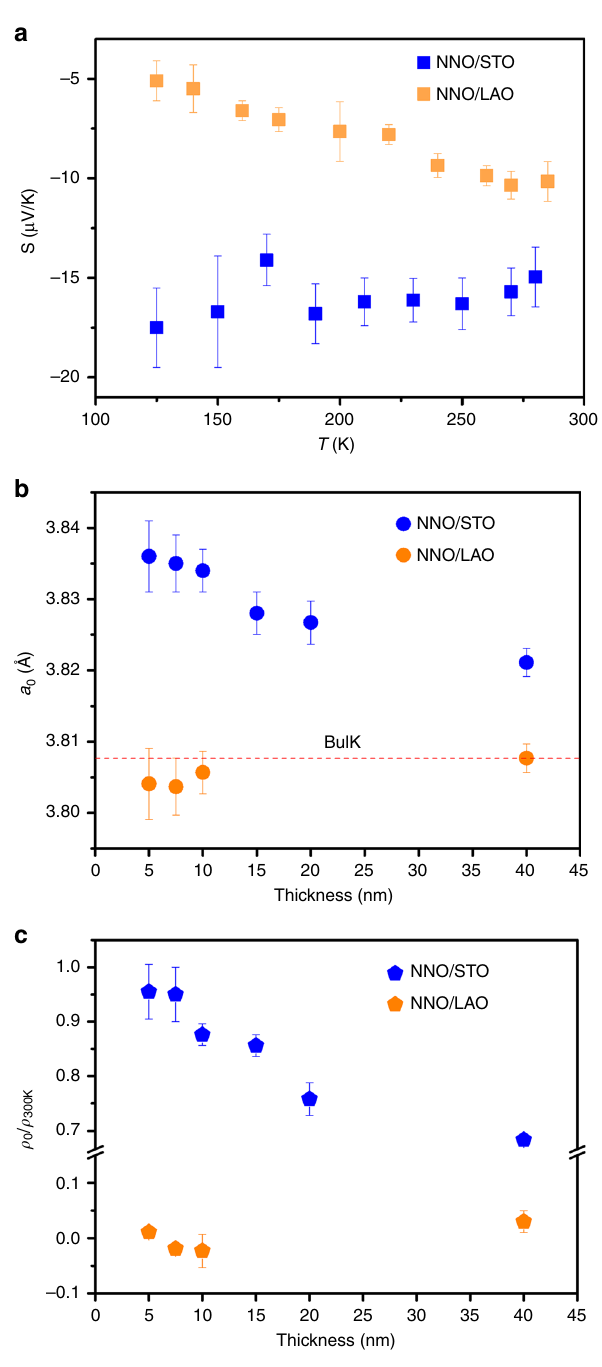
Fig. 6 Oxygen vacancy indicators. a Seebeck coef fi cients ( S ) measured on NNO fi lms with thickness of 10 nm grown on LAO and STO substrates. b The unstrained fi lm lattice parameter (a 0 ) and c the reversed residual- resistivity ratio ( ρ 0 / ρ 300K ) of NNO fi lms grown on LAO and STO substrates with different thickness. The error bar was determined from the deviation of repeated crystals 67 of metallic LaNiO 3 − δ . The controlled tunability of oxygen vacancies with strain and its direct relationship with the transport properties demonstrated could also be of importance in the context of the bond disproportionation and negative charge transfer models 35 , as well as the recent work proposing the metal state as a bipolaron liquid and the insulating phase as its ordered (bond-disproportionated) version 37 .